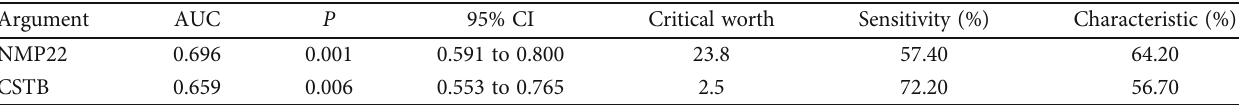
Table 2: ROC curve analysis of preoperative NMP22 and CSTB conveying on the appraisal worth of bladder carcinoma postoperative